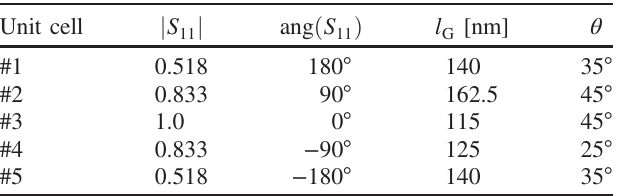
TABLE I. Normalized reflection coefficients of each unit cell in a five-element Dolph-Tschebyscheff reflectarray. The resulting array factor directs its main beam at 56.5° provided that each element radiates isotropically. l and θ represent the length and G the rotated angle, respectively, of each GSP resonator that correspond to the desired S 11 .